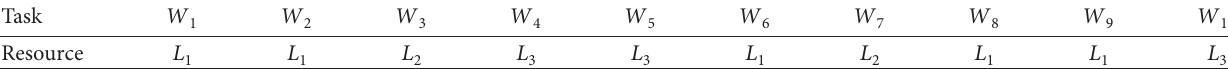
Figure 4: The schedule changes as a result of the function Reallocate. Table 7: Resource-task assignment of new P